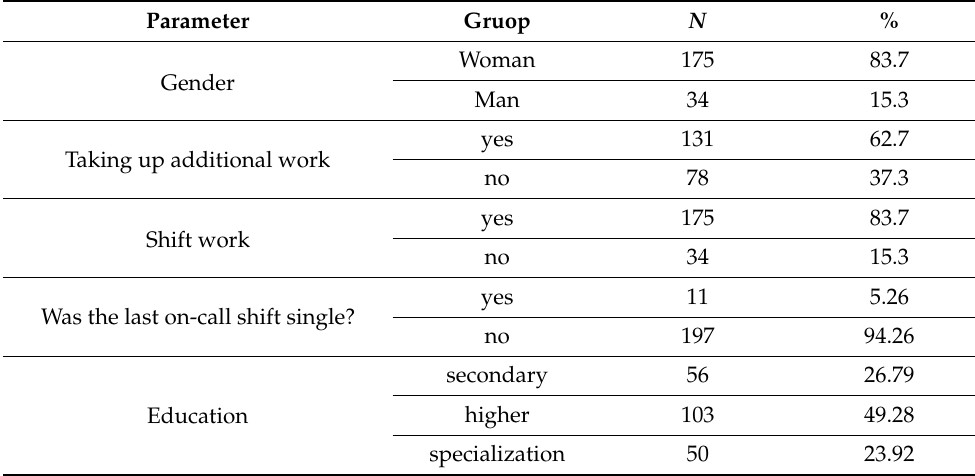
Table 1. Descriptive statistics/demography.